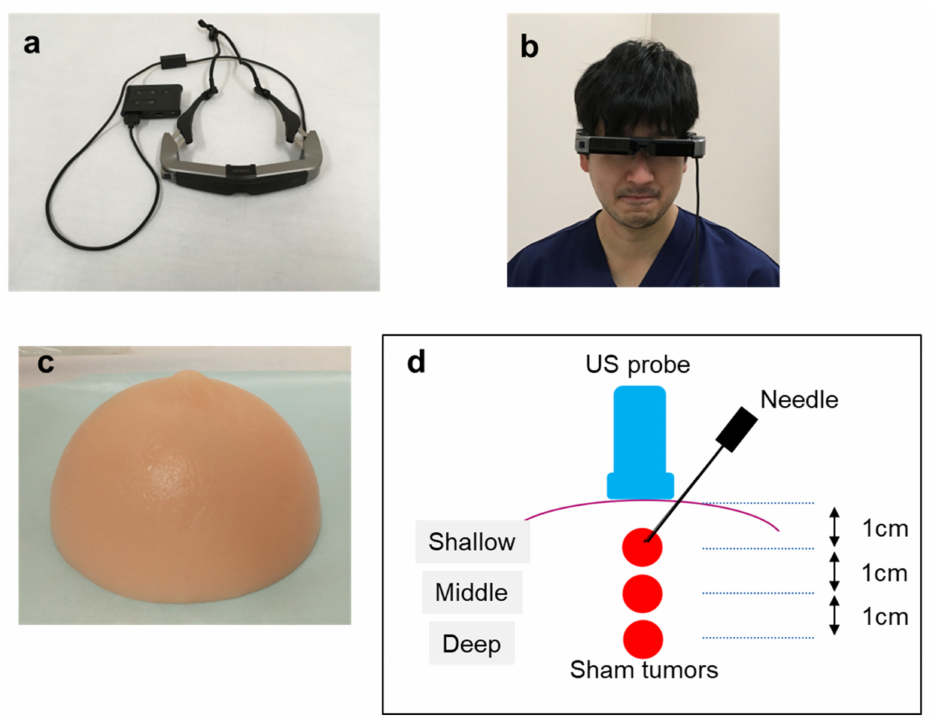
Figure 2. ( a ) OST-HMD (Moverio BT-35E, Seiko Epson Corporation, Suwa, Japan) used in this study. ( b ) Front view of a practitioner wearing OST-HMD. ( c ) Appearance of breast phantom